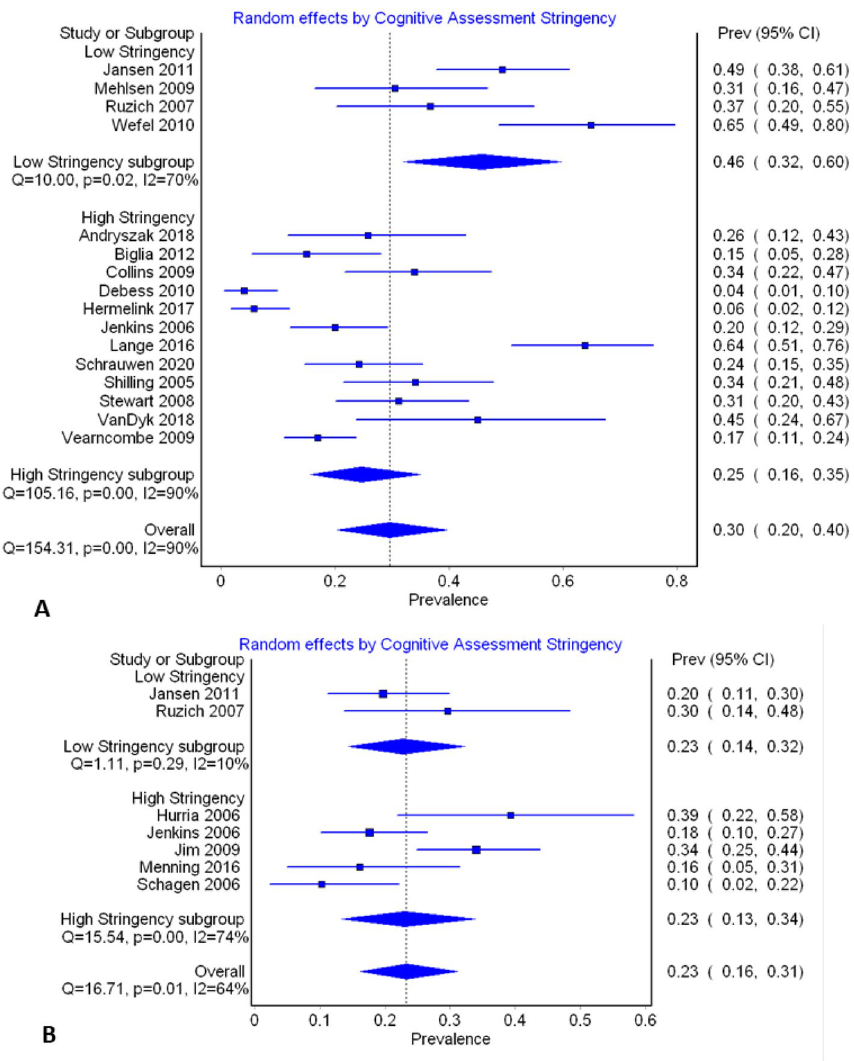
Figure 7. Forest plots of prevalence sub-grouped by stringency of cognitive assessment. ( A ) Cognitive assessment undertaken just after cessation of chemotherapy treatment (T2), ( B ) Cognitive assessment undertaken 6 months after cessation of chemotherapy treatment (T3).